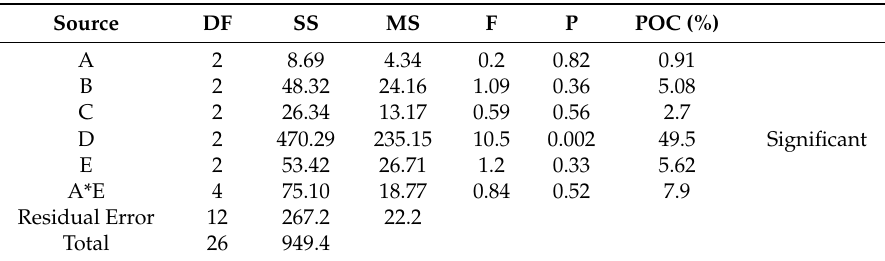
Table 10. S/N ratio analysis for tool wear.